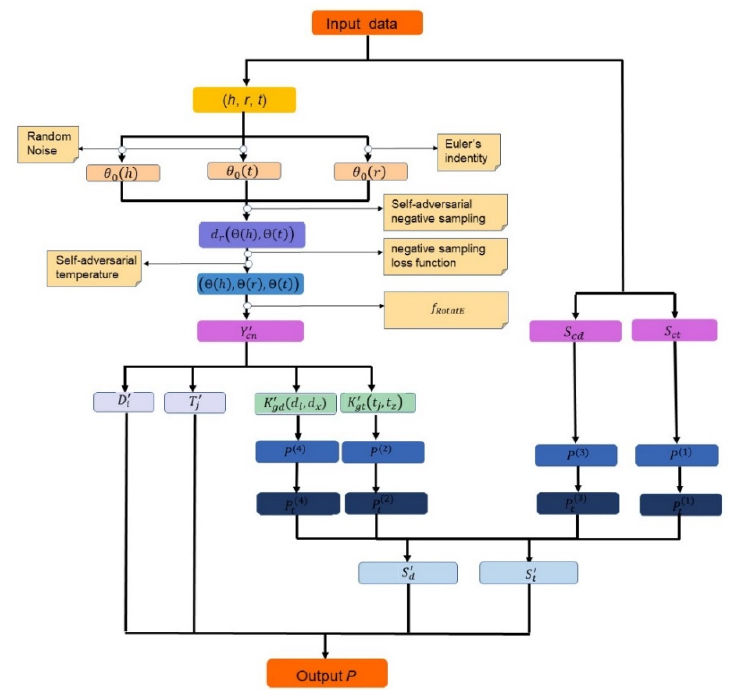
Figure 2. Graphical illustration of the proposed DTI prediction scheme.